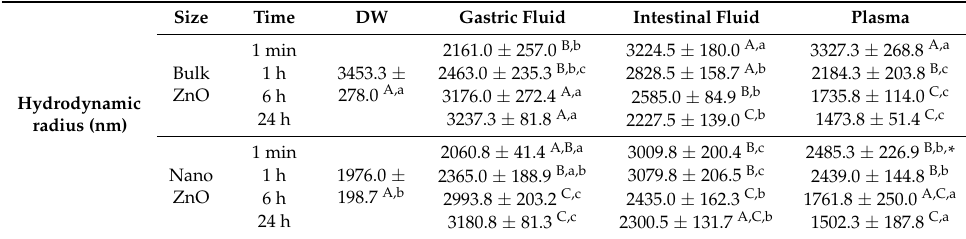
Table 1. Hydrodynamic radii of bulk and nano ZnOs in different simulated biological fluids.